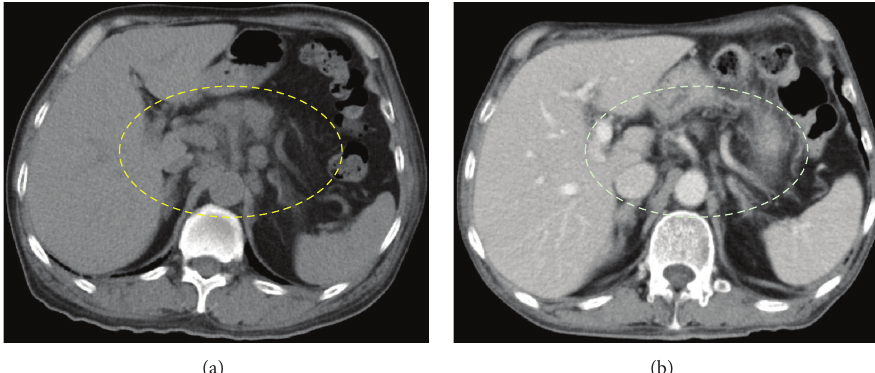
Figure 1: (a) Abdominal CT showing enlarged para-aortic lymph nodes. (b) After four courses of EP, enlarged lymph nodes have completely disappeared.